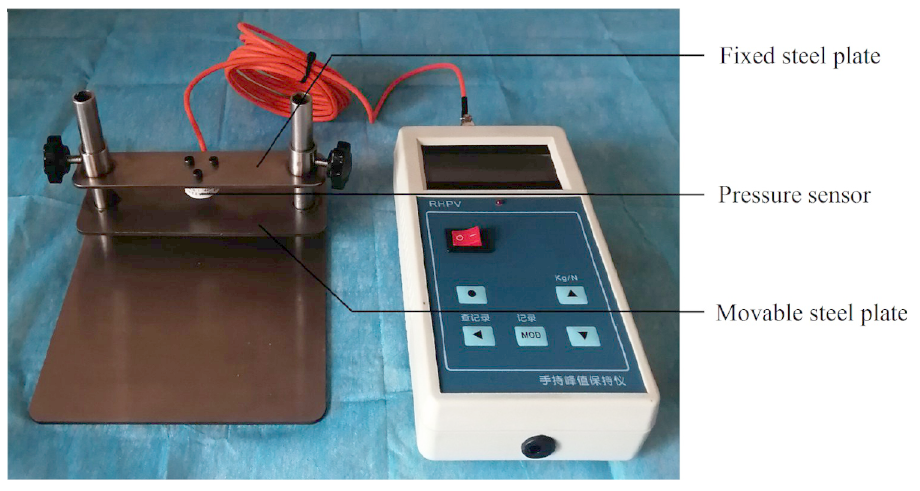
Fig 3. The force measurement